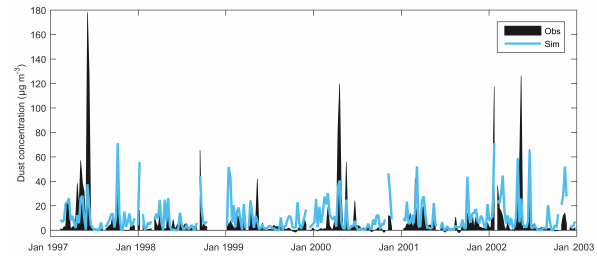
Figure 5. Observed (black) and modelled (blue) weekly mean dust concentration (µgm − 3 ) at Stórhöfði/Heimaey.